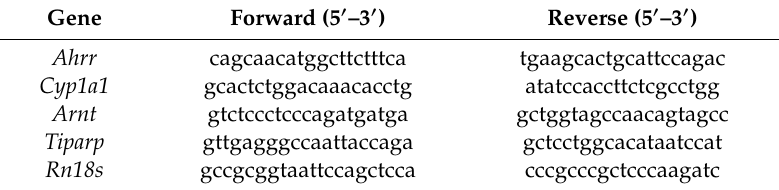
Table 3. Quantitative real-time polymerase chain reaction primer sequences.